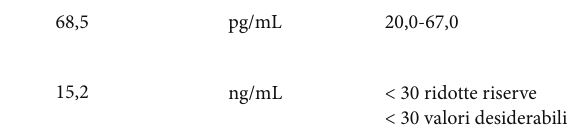
Figure 8: Laboratory test results related to vitamin D: vitamin D values.